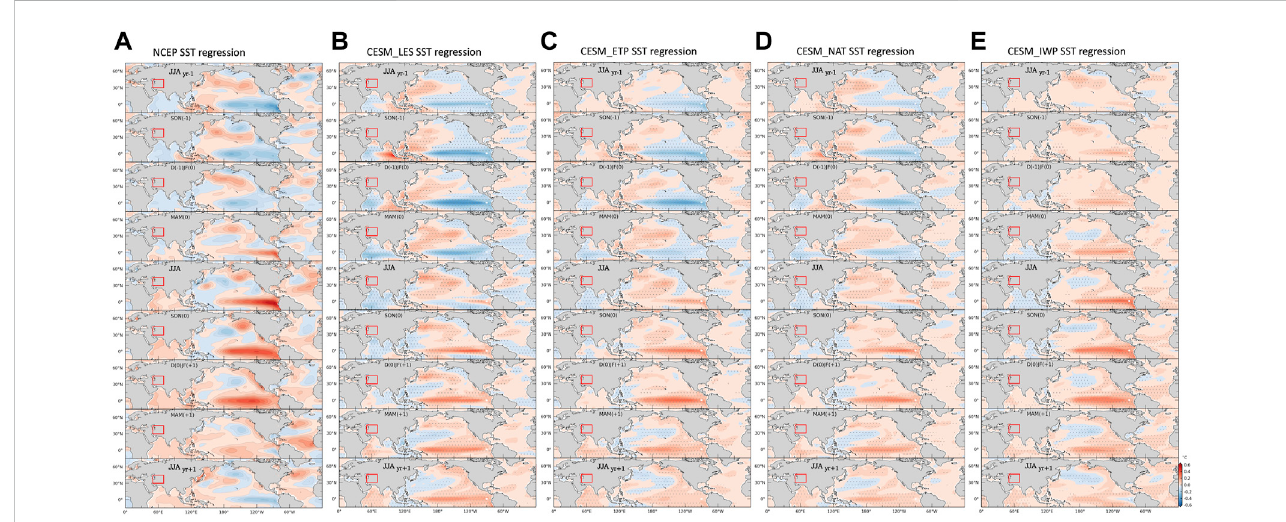
FIGURE 5 The cross regression of SST on summer RWS_CGT index (mean RWS in the red box) from the preceding year ’ sJune — August (JJA yr-1 )to the subsequent year ’ s June — August (JJA yr+1 ) for (A) NCEP, (B) CESM_LES, (C) CESM_ETP, (D) CESM_NAT, and (E) CESM_IWP. The pacemakers use ensemble mean and the red box is the location of RWS_CGT index. The dotted regions indicate the ensemble members agree with the changes at 95% signi fi cance level.